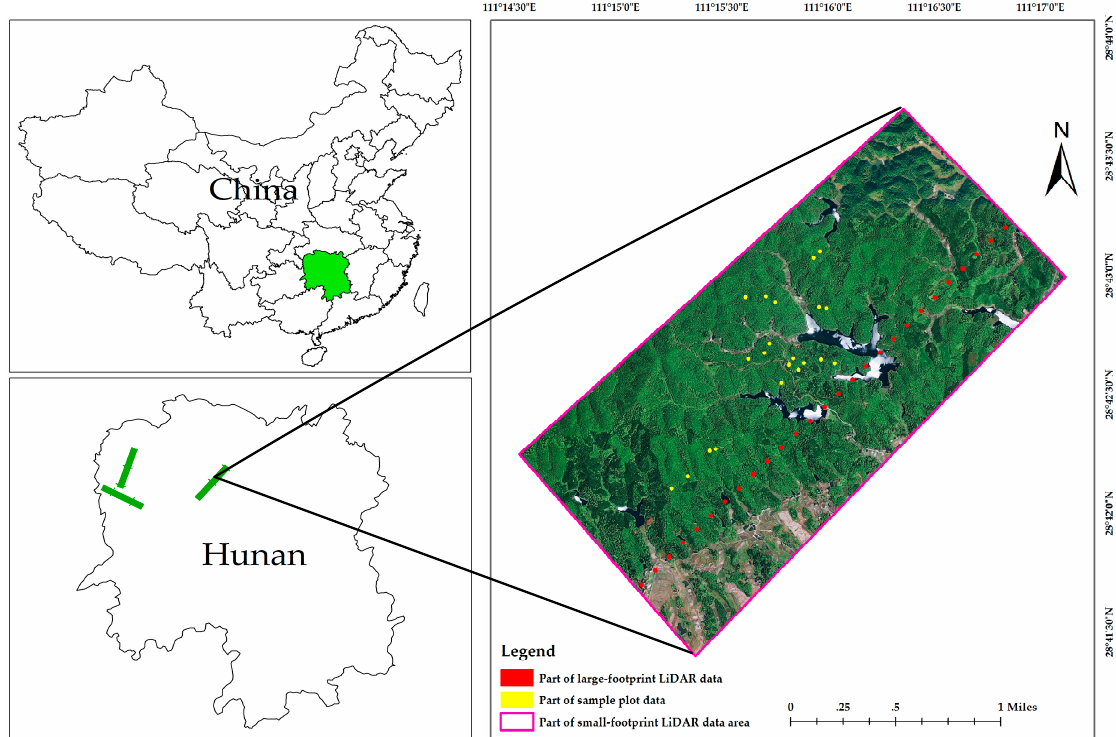
Figure 8. A segment of the flightline on which large-footprint LiDAR data (red points), small-footprint LiDAR (large rectangular area) and ground plots (yellow points) were collected.